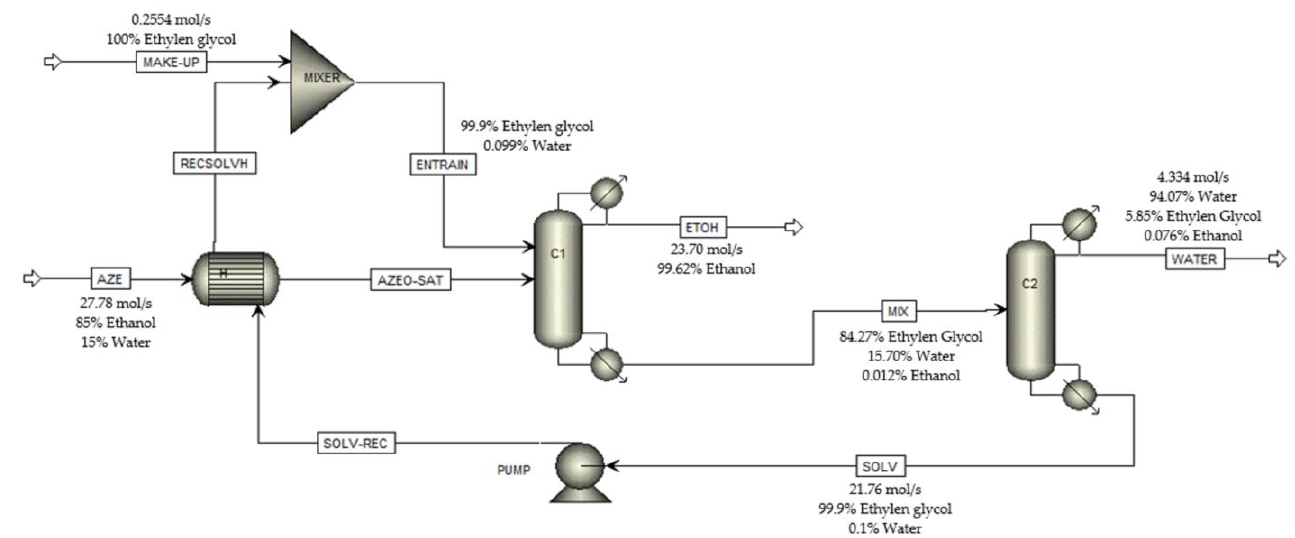
Figure 1. Scheme of the extractive distillation separation system. Source: the authors. Table 1. Energy consumption of the extractive distillation process.